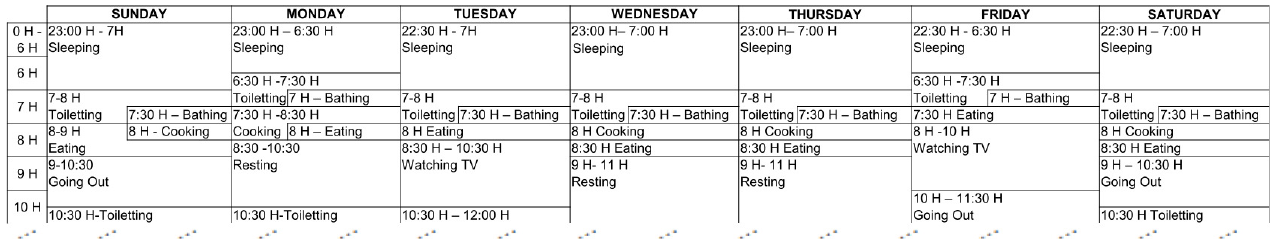
Figure 8. Schedule employed in the